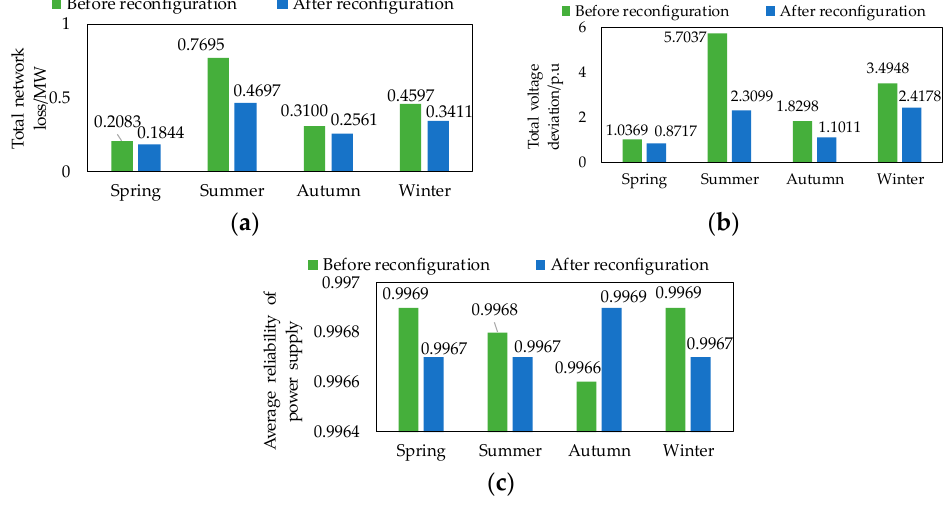
Figure 10. Comparison of results before and after DNR. ( a ) Total network power loss. ( b ) Total volt-